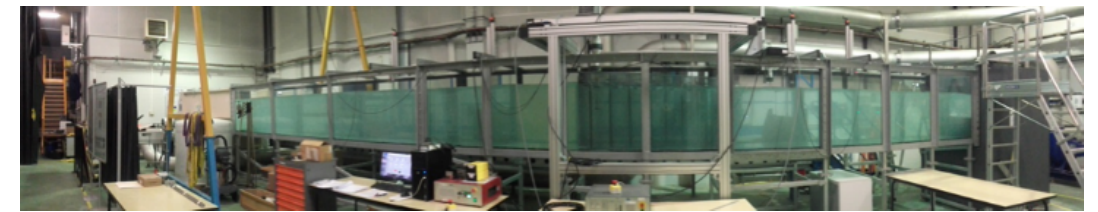
Figure 1. Open flow channel at the Pprime